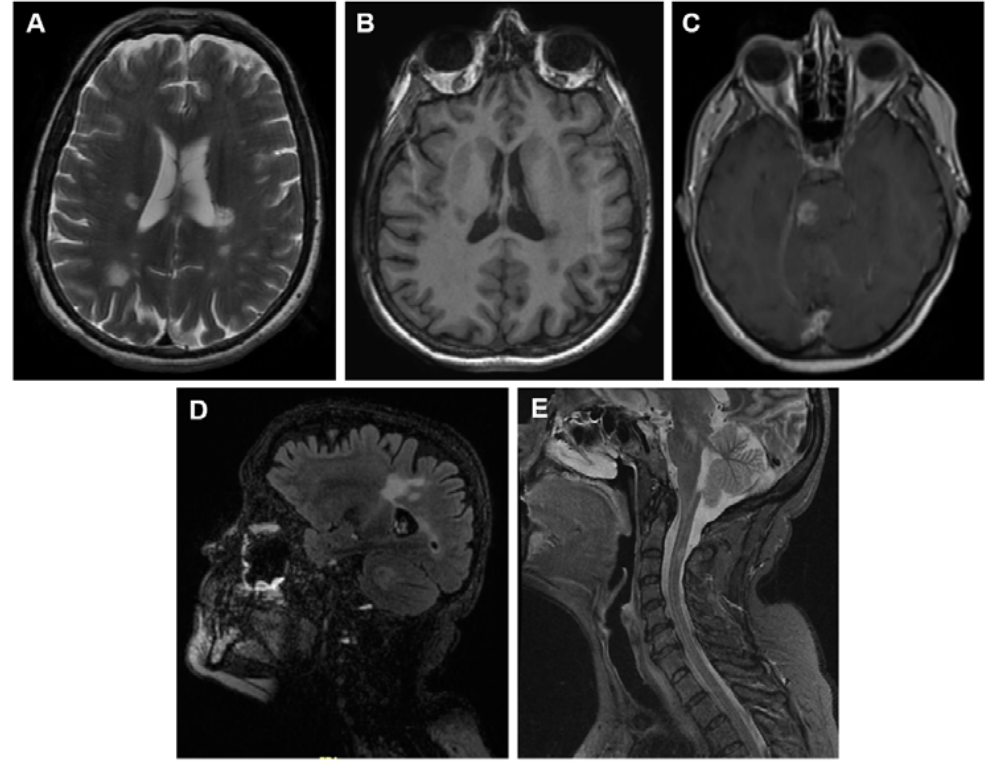
Figure 1. Representative images of MS lesions in the CNS obtained by the magnetic resonance techniques (MRI) most used for diagnosis in daily clinical practice. ( A ) Brain MRI T2-weighted. ( B ) Brain MRI T1-weighted. ( C ) Brain MRI T1-weighted after gadolinium administration. ( D ) Brain MRI FLAIR-weighted. ( E ) Spinal cord MRI STIR sequence.